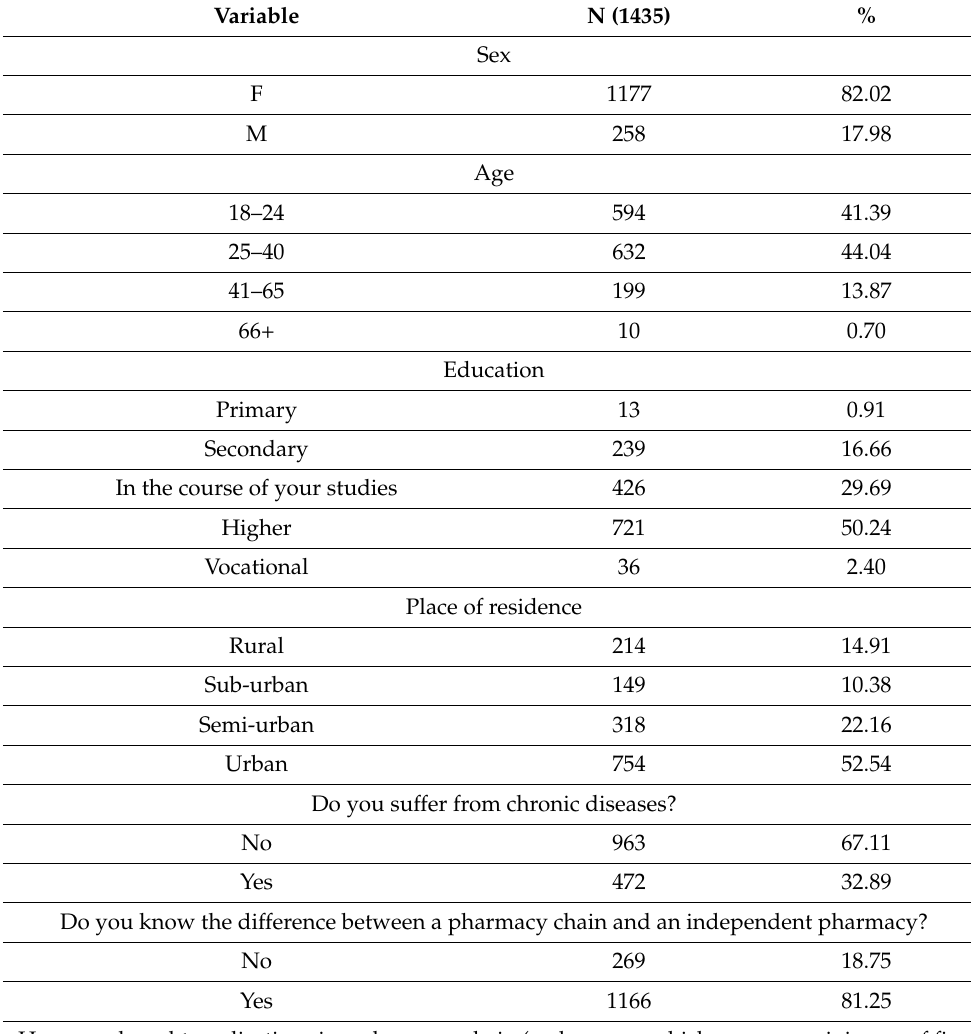
Table 1. Characteristics of the